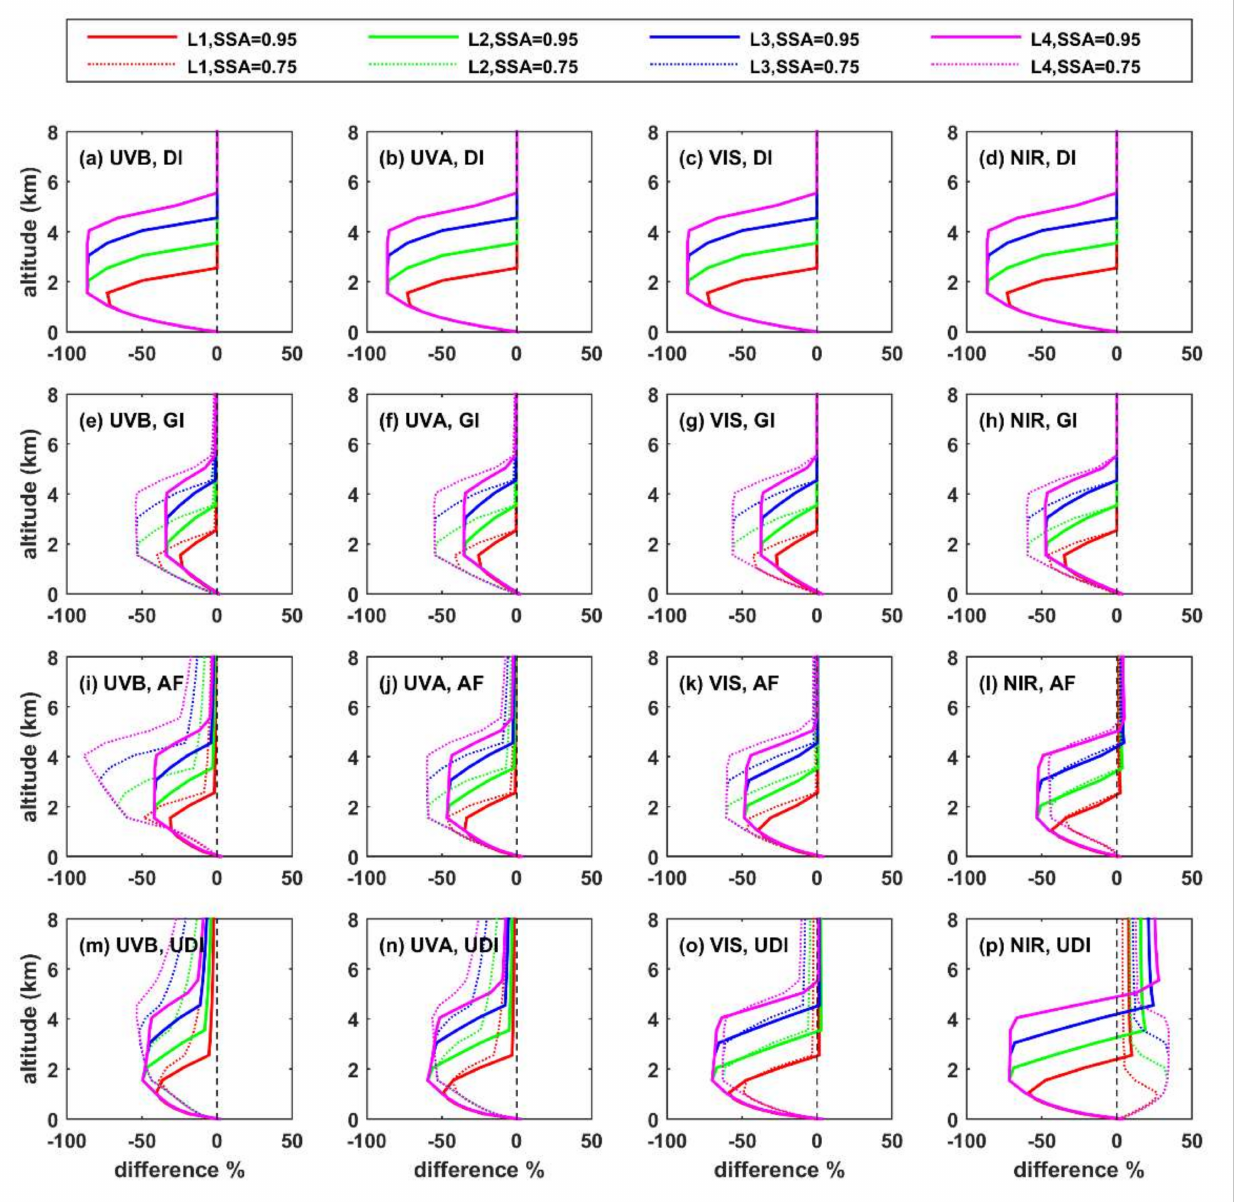
Figure 3. Change (in %) in the profiles of DI (first row), GI (second row), AF (third row), and UDI (fourth row) in UVB (first column), UVA (second column), VIS (third column), and NIR (fourth column). The presented results are for AOD = 1, SZA = 60 ◦ , surface albedo = 0.1, TCWV = 1 g/cm 2 , and two values of the SSA: 0.75 (dotted lines) and 0.95 (solid